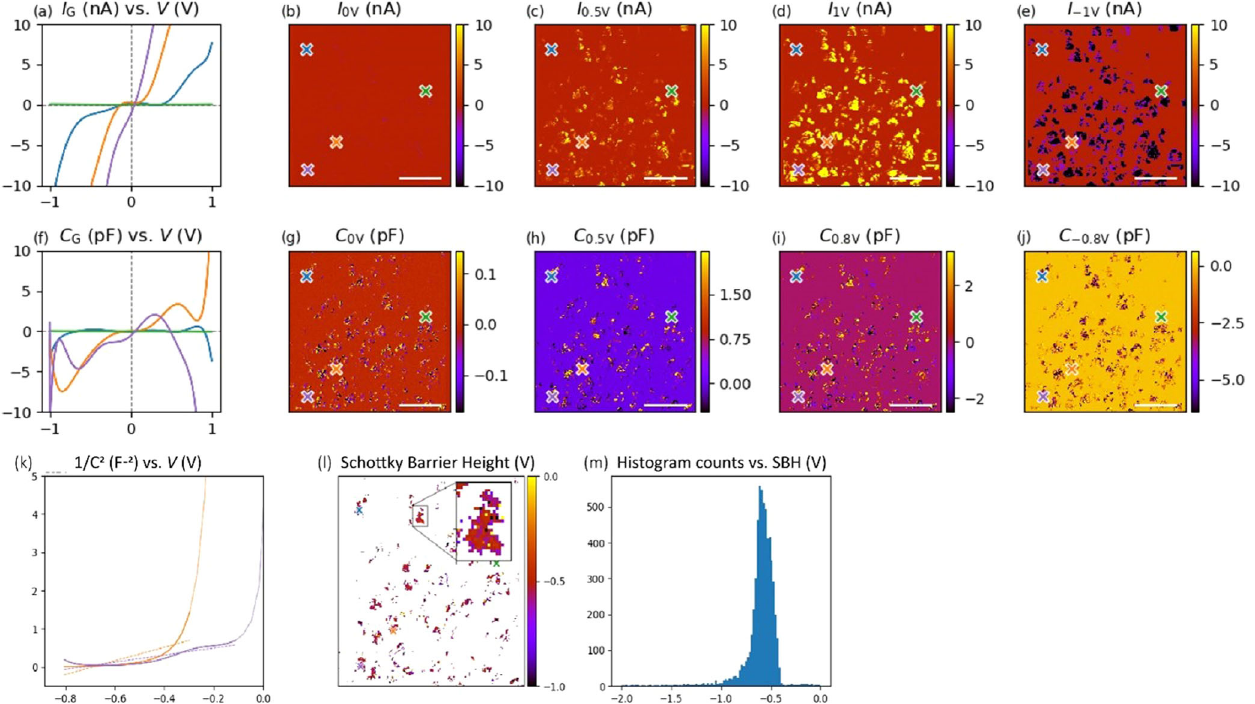
Fig. 3 Interlayer capacitance mapping and localized barrier modulation. a A rGO(30 cycle)/Fe 3 O 4 surface of 1 × 1 µm 2 imaged in ImCFM mode. Current maps measured at applied 0, 0.5, 1, and − 1 V bias (upper row, b – e ) and corresponding capacitance maps (bottom row, g – j ). Corresponding J-V curves taken at the green, orange, blue and violet marks are shown in a . The green mark shows the J-V curve measured on location without rGO network presence, while the J-V curves measured on spots where rGO network is present under the SC fi lm are shown in the blue, violet and orange marks and are shown in a . The corresponding capacitance curves are shown in f . Green mark is taken in the area without any clear illumination effect. The calculated Schottky barrier heights for the taken J-V curves are shown in k . The reconstructed Schottky barrier height map is shown in l and corresponding distribution histogram is in m . The scale bar in the image is 200